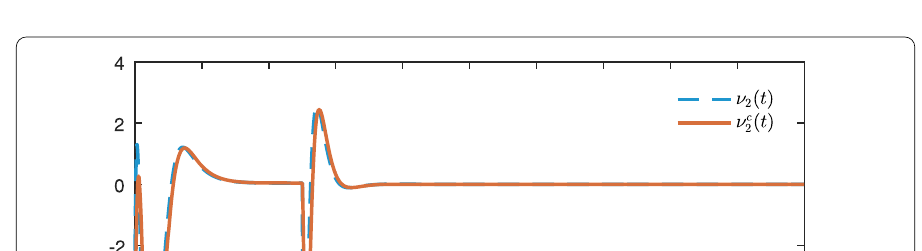
the controlled system suffers from parametric uncertainty and external disturbances. It has been proven that our method is feasible for a wider range of SFNSs than conventional ABC and the dynamic surface can also be utilized to enhance constraints on the state tra- jectories. The proposed ADSC guarantees that all signals in the closed-loop system keep bounded and tracking errors converge to a sufficiently small region. The effectiveness of our method has been verified by a simulation results. Our future research direction in- clude: (1) Design an extended controller consider how to deduce the requirement of the system model; (2) Combined our method with some robust control approach, for example, adaptive fuzzy control, adaptive neural network control, sliding mode